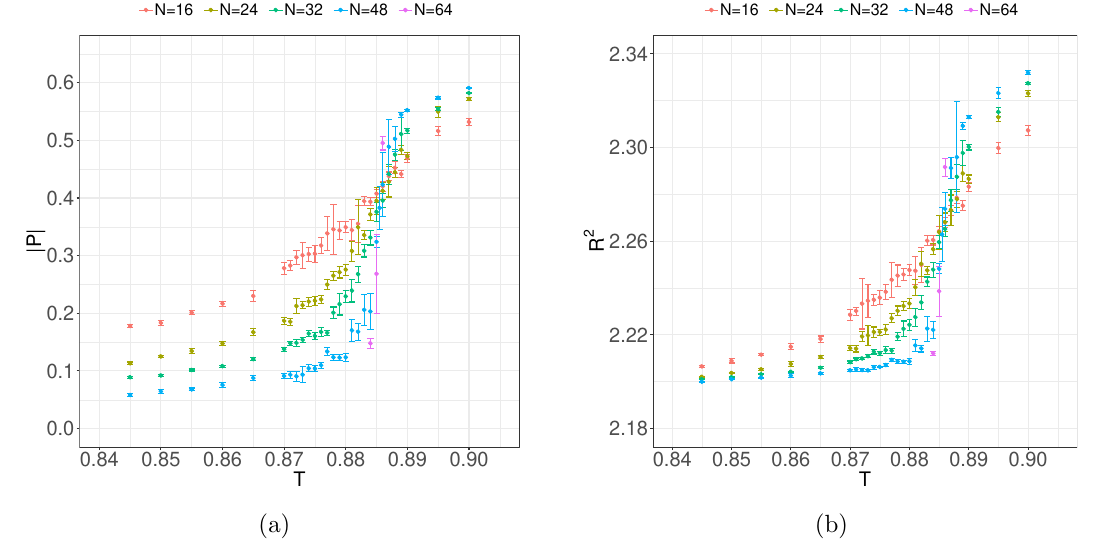
Figure 4. a) j P j vs T and b) R 2 vs T , both for L = 24, D = 10 and various N